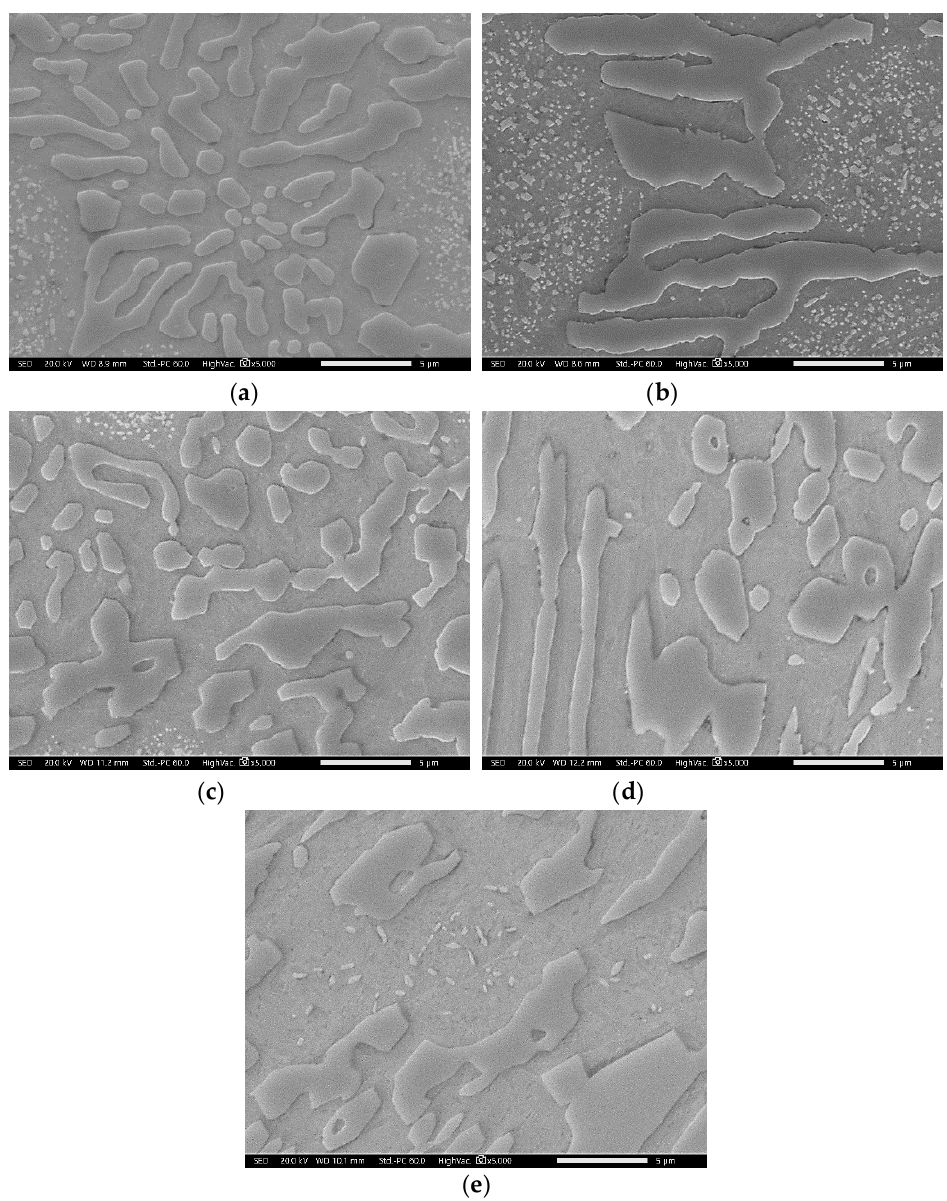
Figure 7. SEM micrographs of the conventionally heat-treated interdendritic eutectic region: ( a ) 2124; ( b ) 2127; ( c ) 2427; ( d ) 2827; ( e ) 2927.